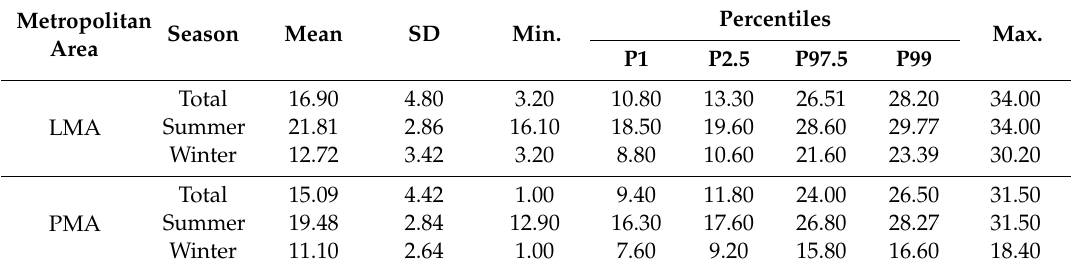
Table 2. Descriptive statistics for the mean daily temperatures in Lisbon metropolitan area (LMA) and Porto metropolitan area (PMA),